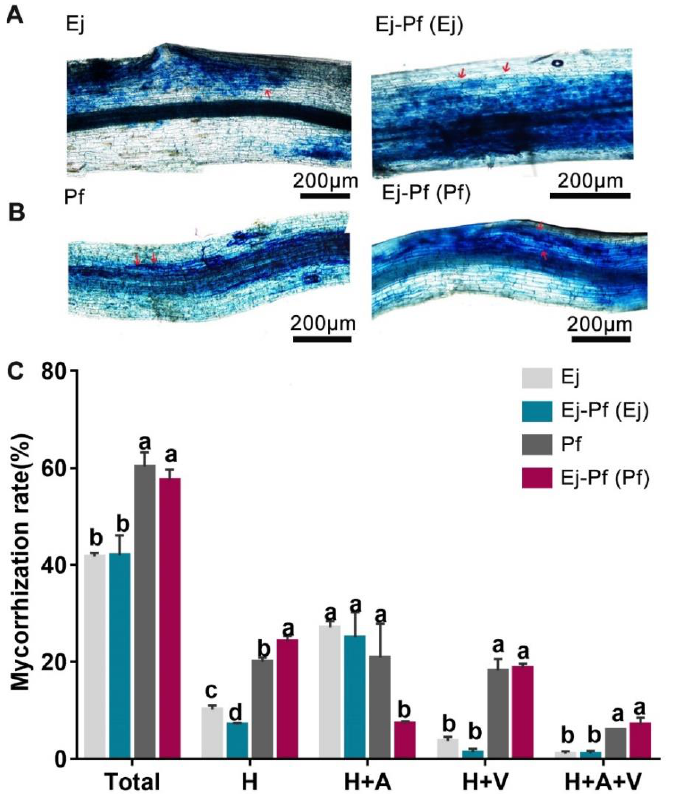
Figure 4. The analysis of the mycorrhization rate of P. × fraseri and E. japonicus in the monoculture and intercropping systems. ( A ) and ( B ) Images of E. japonicus and P. × fraseri roots, bar = 200 µm. ( C ): Quantification of the mycorrhization rate level of P. × fraseri and E. japonicus plants. Ej and Pf refer to E. japonicus and P. × fraseri in the monoculture system, respectively; Ej-Pf and Pf-Ej (Pf) refer to E. japonicus and P. × fraseri in the intercropping system, respectively. A, H, and V represent “arbuscules”, “hyphae”, and “vesicles”, respectively; A + H (%) indicates the percentage of root with arbuscules and hyphae; A + V + H (%) represents the percentage of root with arbuscules, vesicles, and hyphae; H (%) indicates percentage of root with only hyphae; and V + H (%) indicates the percentage of root with vesicles and hyphae. Red arrows indicate arbuscules. All values are presented as the mean ± standard error ( n = 4), and bars with different lowercase letters indicate significant ( p < 0.05) differences between the treatments and control, according to Duncan’s